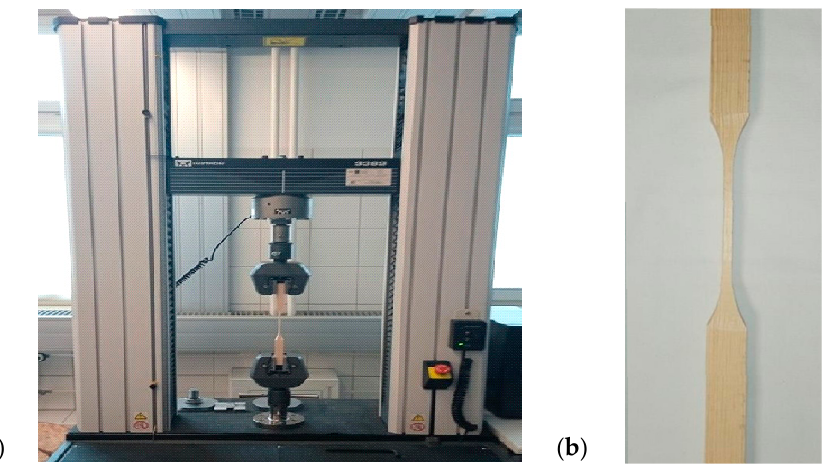
Figure 2. ( a ) Test stand with suction tensile holders for tensile testing; ( b ) samples used for tensile testing.